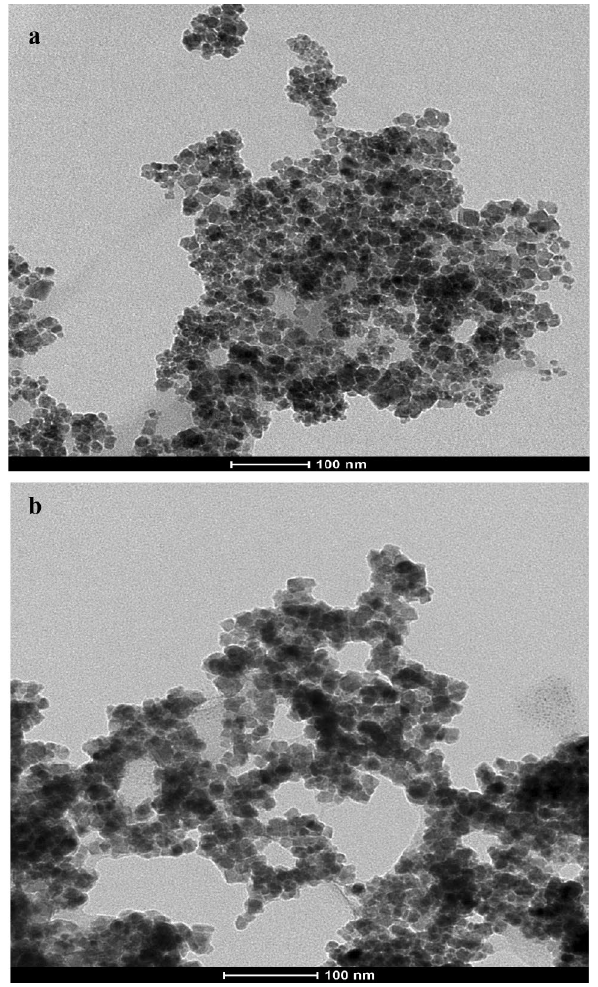
Fig. 3 TEM analysis of a SPIONs, b chitosan-coated SPIONs